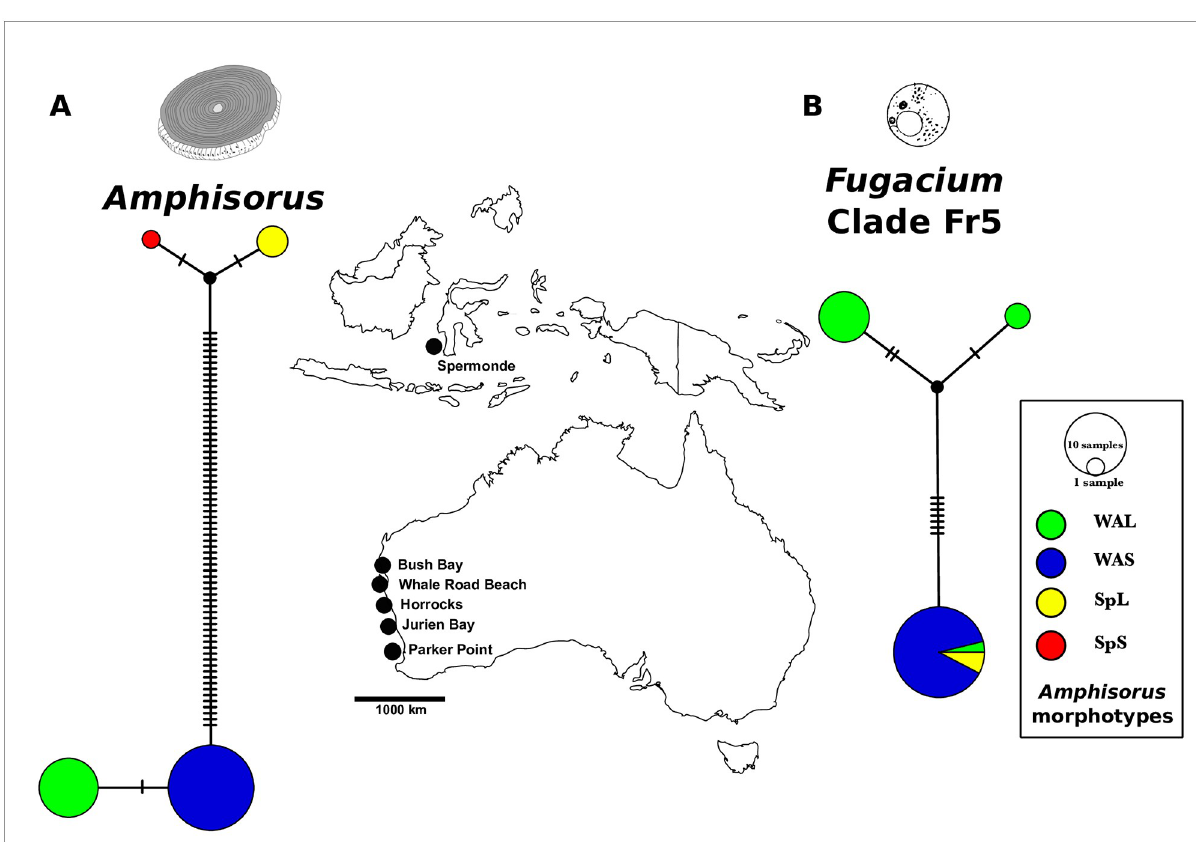
Fig 4. Map showing the sampling locations in Australia and Indonesia, and median-joining networks showing the four Amphisorus genotypes (based on a 4,307bp fragment spanning the partial 18S rRNA, 5.8S rRNA, and partial 28S rRNA), and three Fugacium Fr5 genotypes (based on a 606bp 28S rRNA fragment). Each circle in the network represents a distinct genotype. Colours indicate the morphotype of analysed Amphisorus specimens. Each black bar indicates one substitution. Circle size corresponds to the number of specimens.